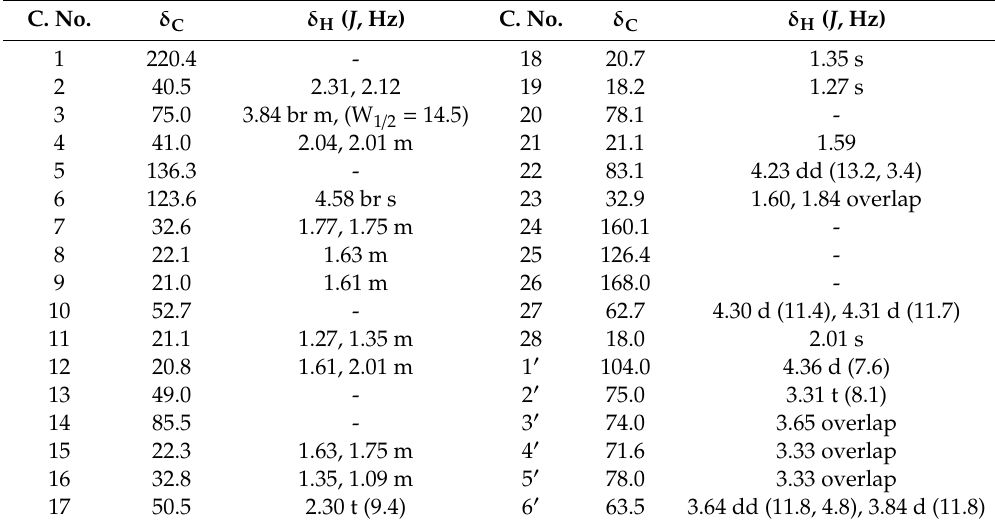
Table 1. 1 H- and 13 C—NMR chemical shift values of compound 1 (ppm, CD 3 OD, 600 and 150 MHz